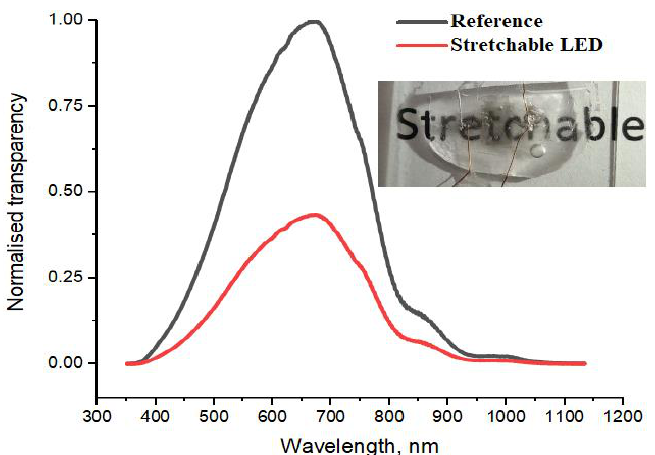
Figure 3. Stretchable LED spectral transparency ( red line ) normalized to the peak value of a refer- ence glass substrate ( black line ). Inset shows a photo of the LED device on reference glass substrate put on a paper with a printed word.